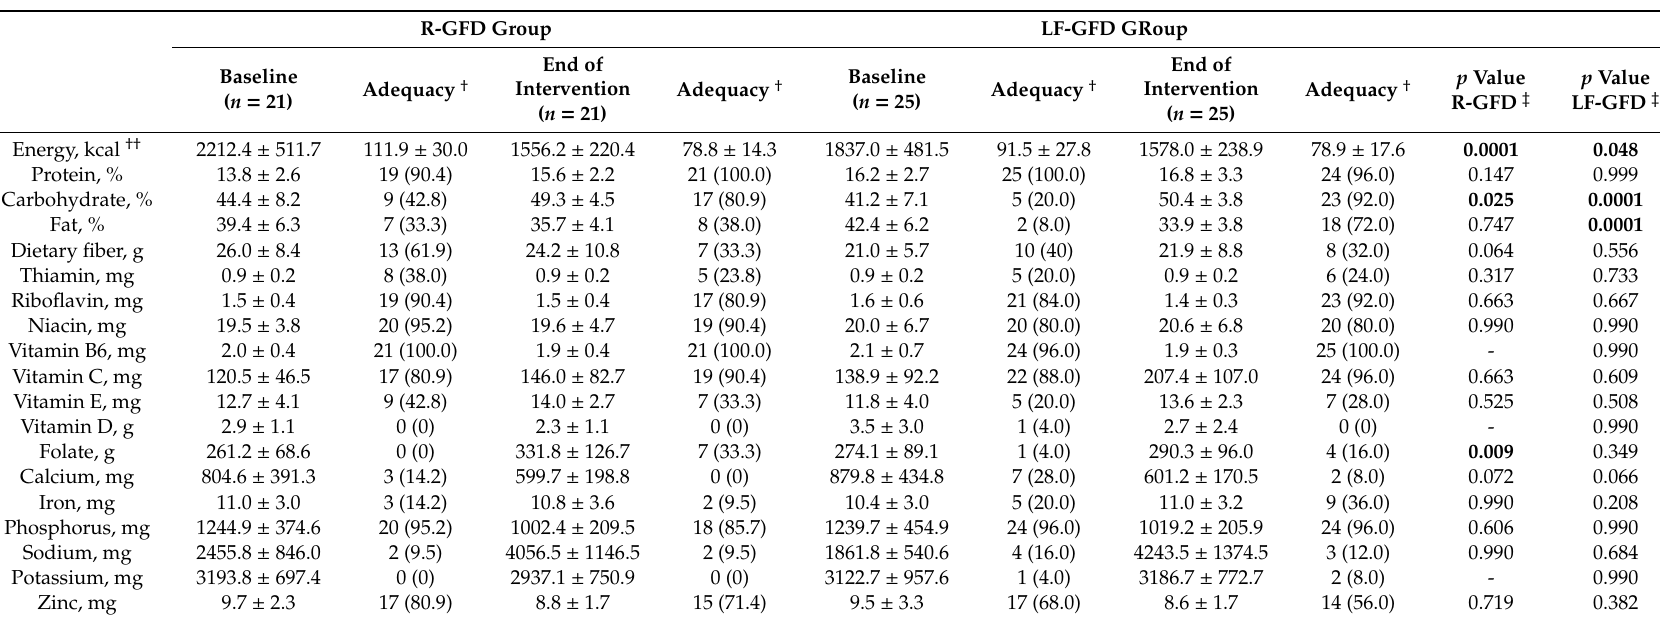
Table 1. Nutritional composition of diets and nutritional adequacy of macro and micronutrients against the daily recommendations in both